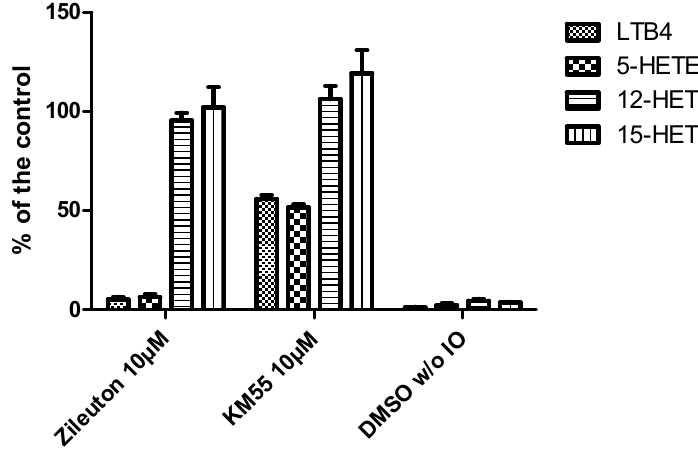
Figure 2. Inhibitory effect of zileuton and KM55 on lipoxygenase product formation in human whole blood. Data are expressed as mean ± S.E.M. ( n = 3).